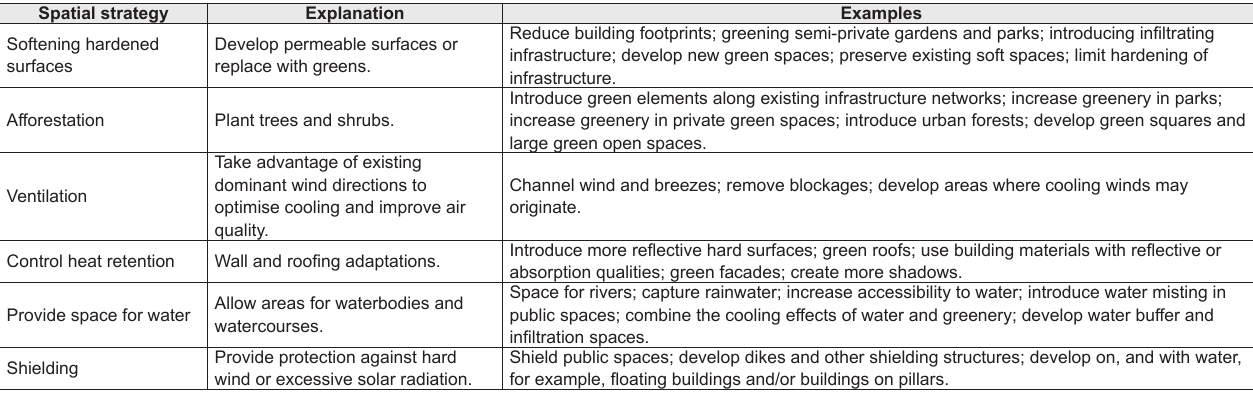
Six spatial strategies for climate adaptation from Belgium Spatial strategy